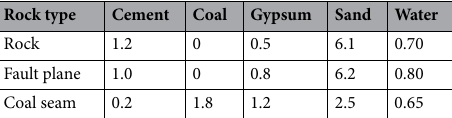
Table 5. Material ratio parameters included in the blasting experiment for rock, fault plane, and coal seam.